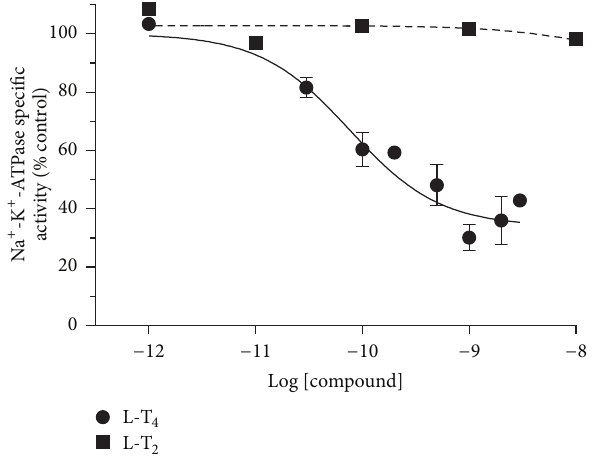
Figure 2: Inhibitory effect of various doses (0.001 nM–10nM) of T 4 orT 2 onsynaptosomalNa + -K + -ATPaseactivity, invitro .Thedataare represented as mean ± SEM of four separate experiments, taking six animals in each group. The vertical lines denote SEM. Filled circles indicate effects of T 4 on Na + -K + -ATPase activity while filled squares indicate effects of T 2 .